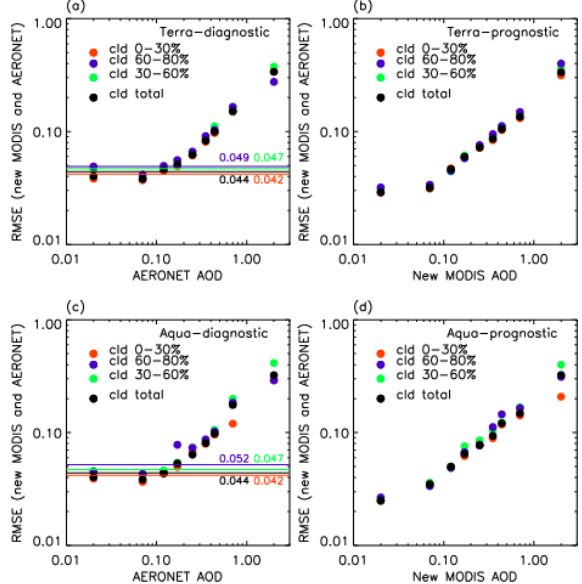
Fig. 7. RMSE of MODIS Terra and Aqua C5 AOD compared to AERONET AOD as a function of AERONET AOD and MODIS AOD. Data under different cloud fraction conditions are indicated with different colors. Red, green purple, and black represent data with cloud fraction between 0—30%, 30–60%, 60–100%, and with total clouds.